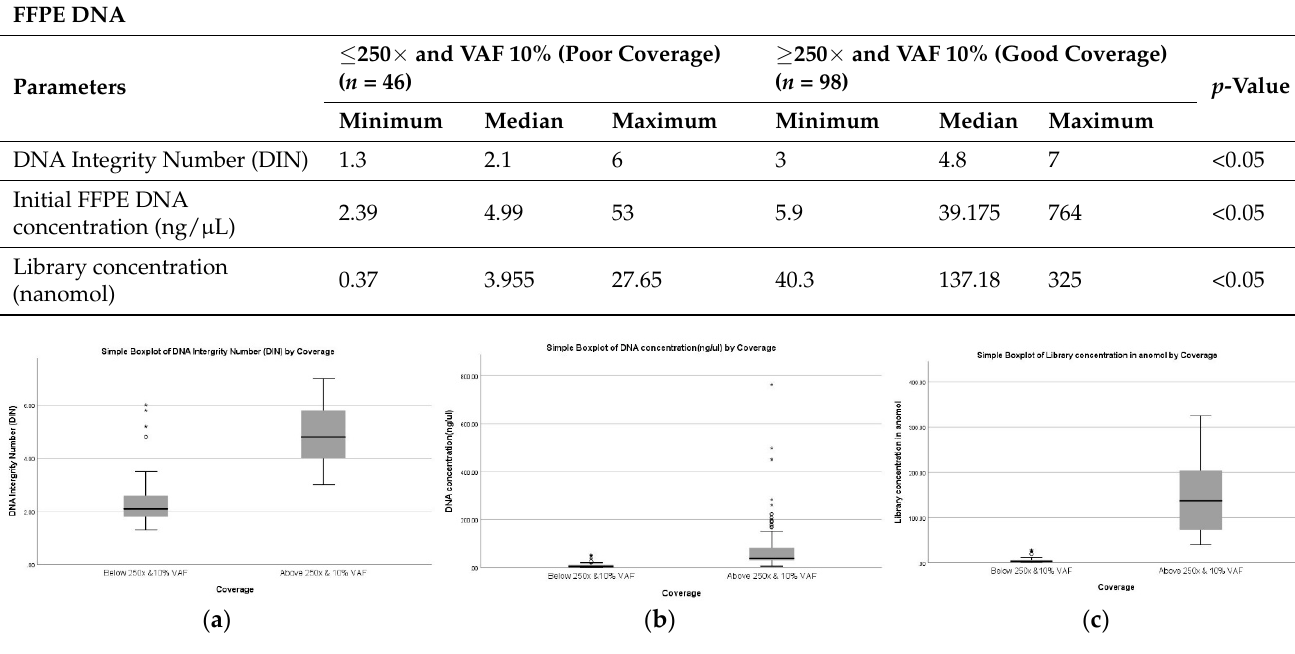
Figure 3. Graphical representation of parameters in FFPE DNA samples according to NGS coverage.